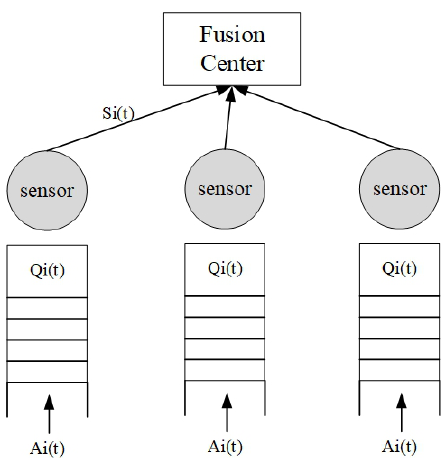
Figure 2. Scheduling process of the decision packets between the sensor and the fusion